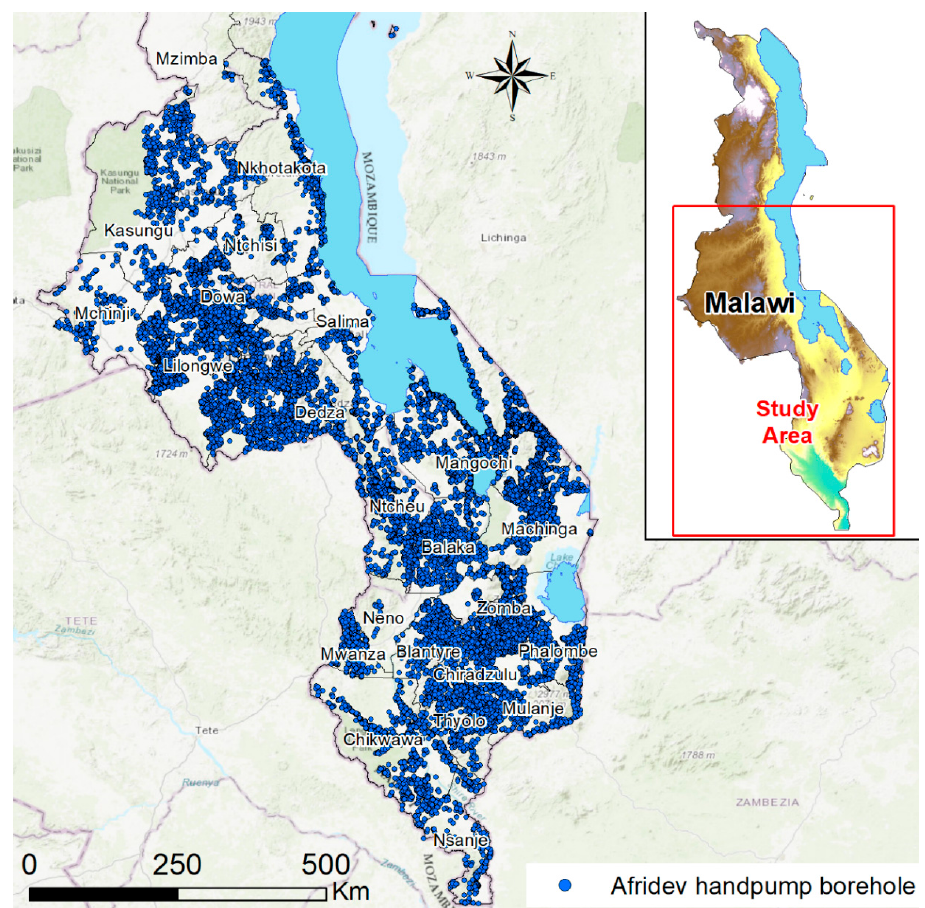
Figure 1. Afridev hand pump boreholes installed between 2000–2016 mapped to date by the CJF (n = 14,943 as of January 2019, with mapping generally proceeding from south to north).